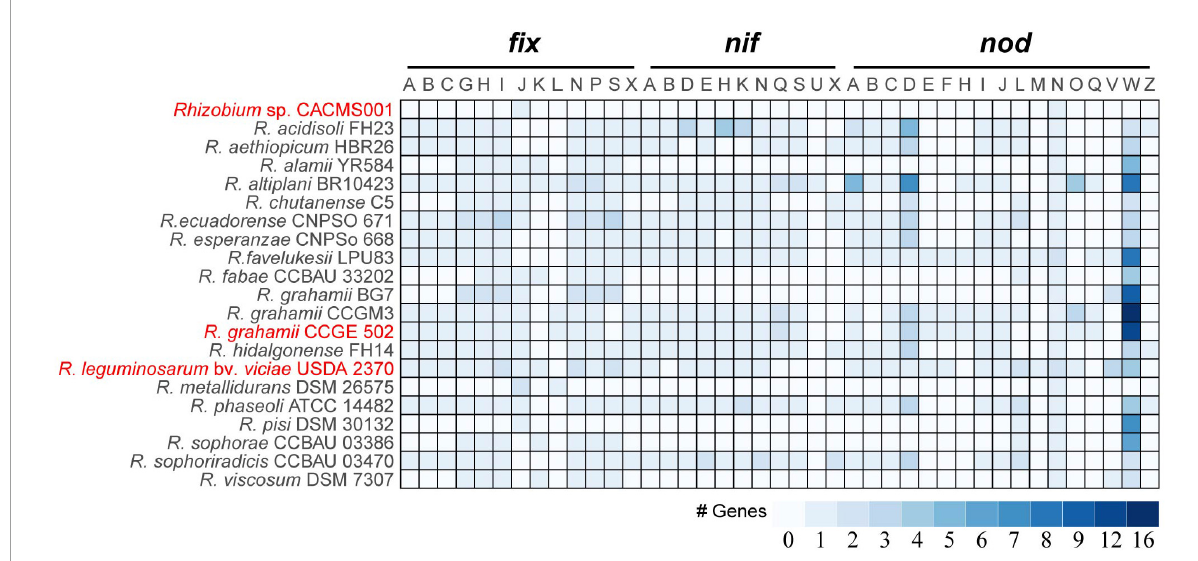
FIGURE5 nif , fix , and nod genes in Rhizobium species. Red words represent species whose effect on P. umbellatus and A. gallica have been evaluated.